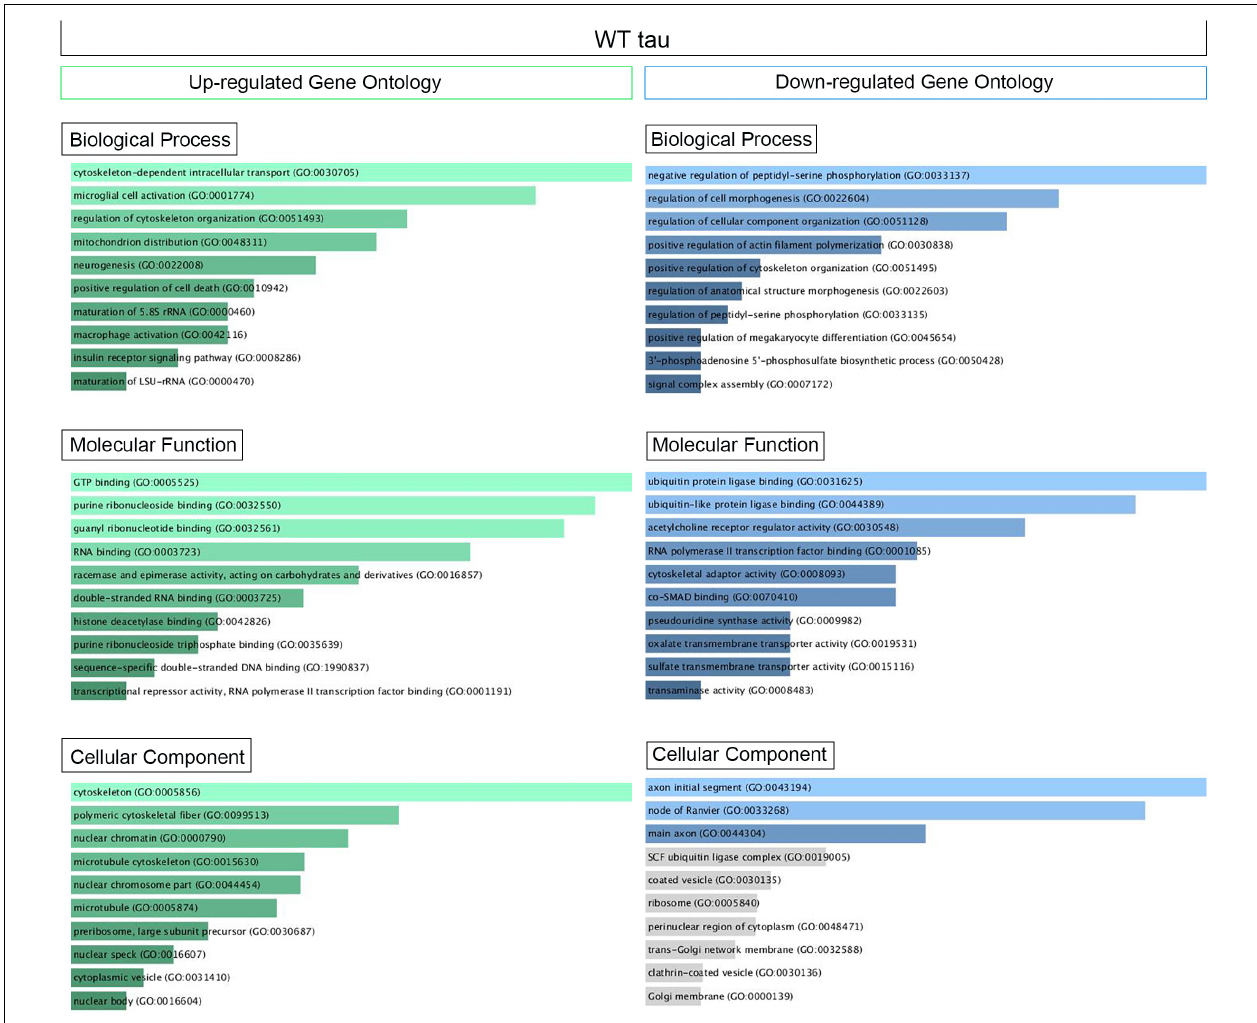
FIGURE 2 | Up- and Down regulated genes in WT Tau iHEK Gene Ontology. Left Column (Green) Up-regulated genes analyzed by Enrich GO and divided by Biological Process, Molecular Function and Cellular Component. Right Column (Blue) Down-regulated genes analyzed by Enrich GO and divided by Biological Process, Molecular Function and Cellular Component. Gray bars represent not significant